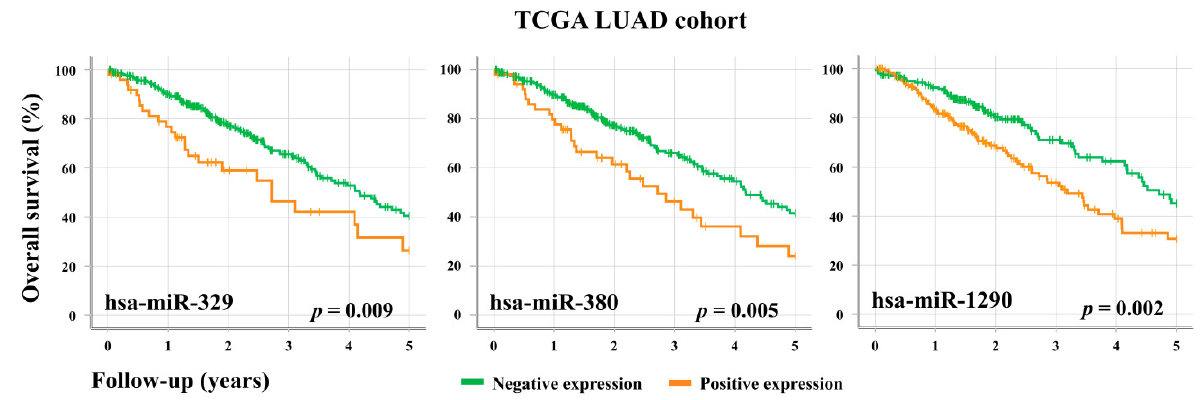
Figure 4. Overall survival of LUAD patients is associated with the expression levels of specific oncofetal miRNAs. TCGA LUAD patients ( n = 379) were stratified according to their level of expression of the oncofetal miRNAs hsa-miR-329, hsa-miR-380, and hsa-miR-1290. For an individual miRNA, RPM < 1 was considered to be negative expression, while RPM ≥ 1 was positive expression.